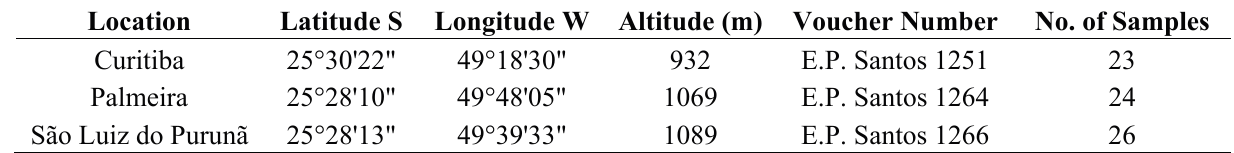
Table 3. Location and samples size of three populations of Salvia lachnostachys